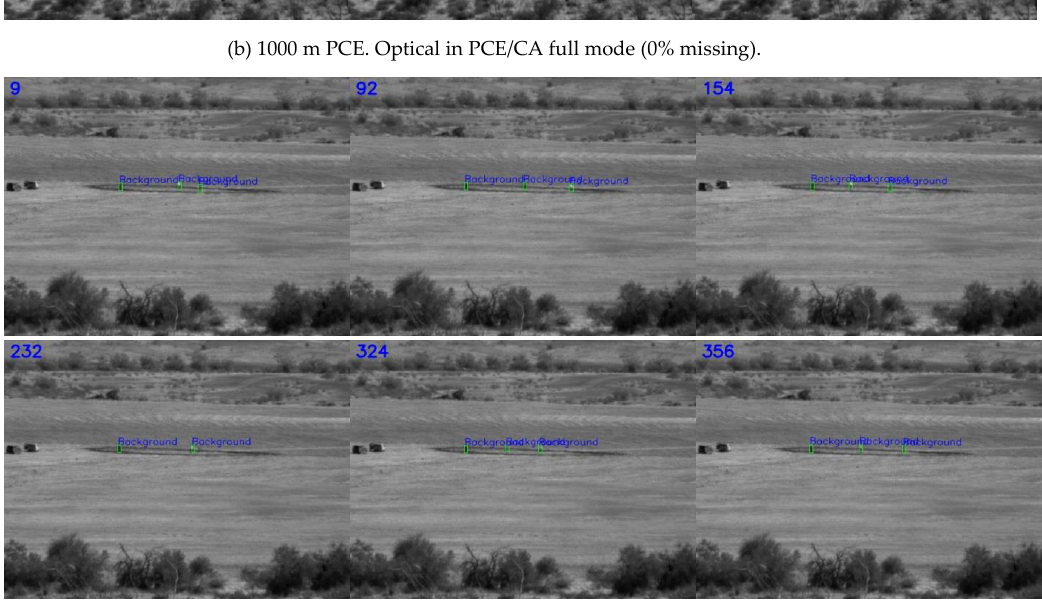
Figure 3. Detection results using optical coded aperture in PCE/CA full mode (0% missing). CA, coded aperture.